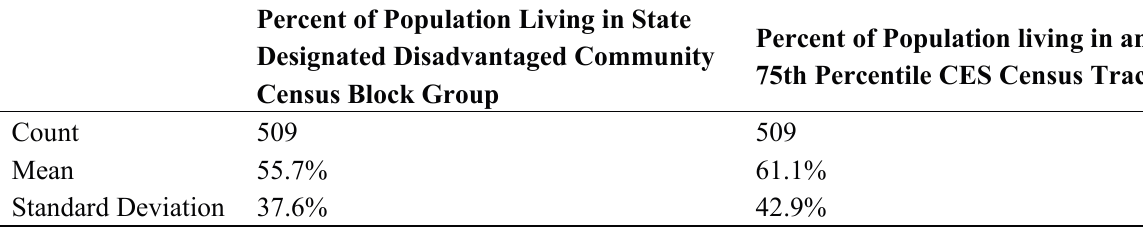
Table 2. Descriptive Measures of Socioeconomic Disadvantaged (SED) Status